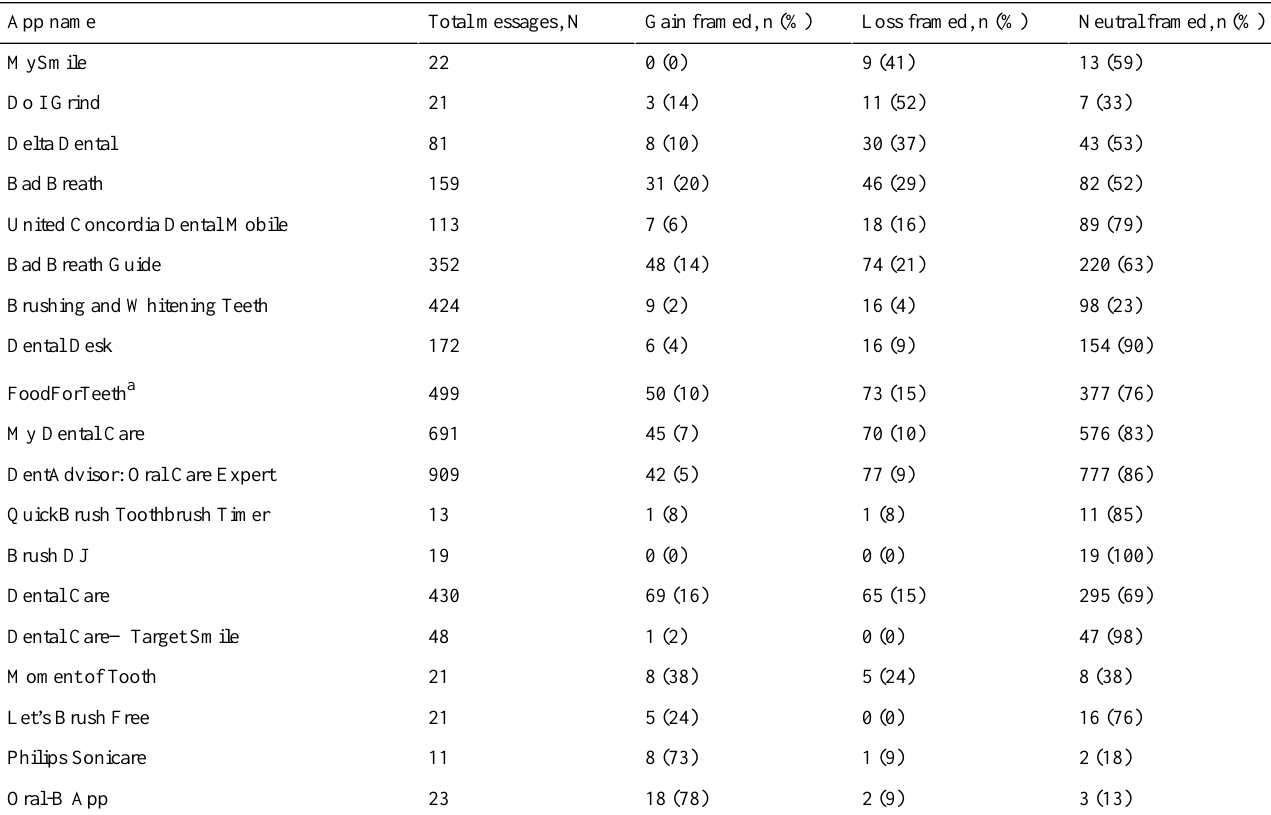
Table 4. Gain and loss framing in apps with persuasive health messages. Table does not include apps that provided instructional content only